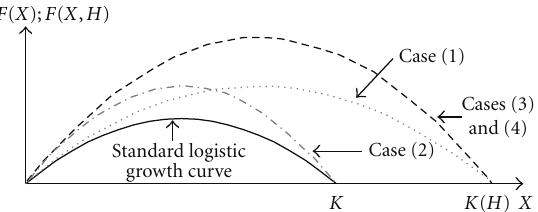
Figure 2: Habitat e ff ects on the logistic growth curve. The black solid line shows the standard logistic growth curve, while the dashed black line shows the positive e ff ect of habitat on both the carrying capacity and intrinsic growth rate (Cases (3) and (4)). The grey lines show the influence of habitat on intrinsic growth (Case (2)) and carrying capacity individually (Case